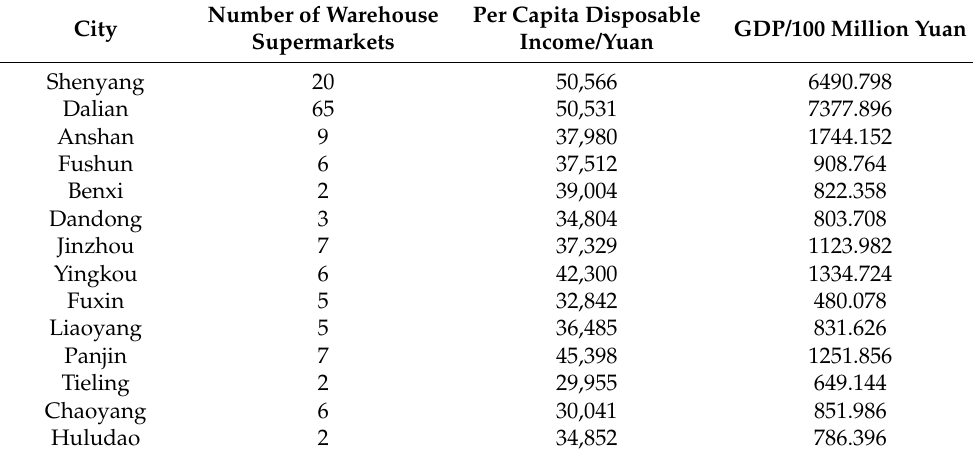
Table 3. Index Data of Cities in Liaoning Province from 2018 to 2022.